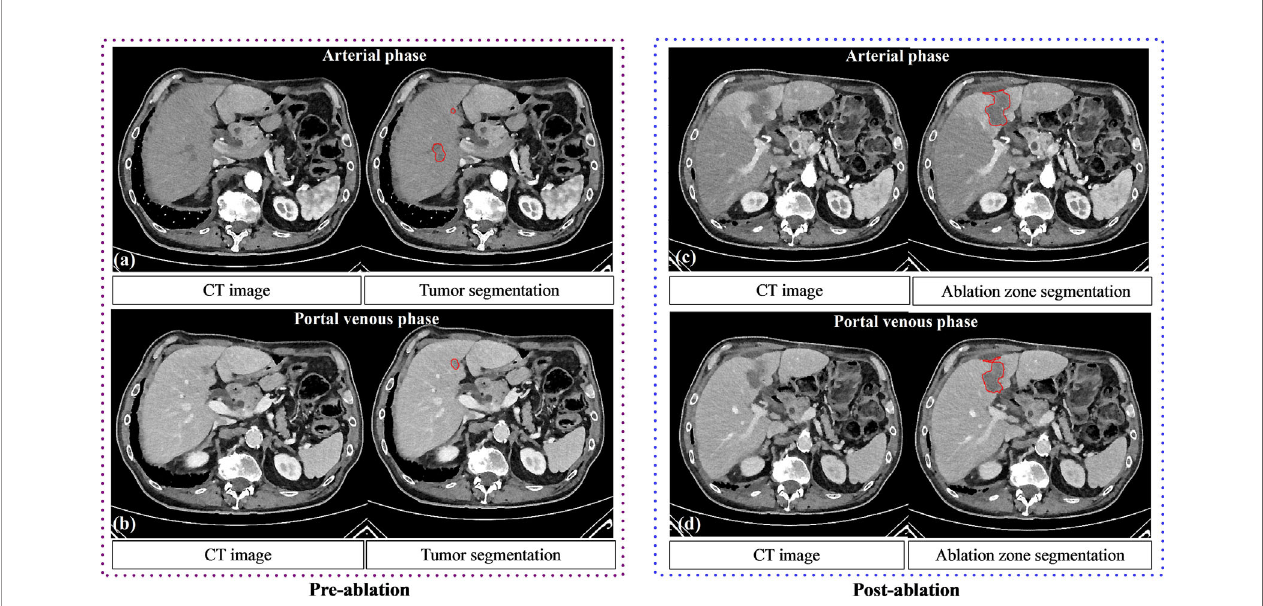
FIGURE 3 | The performance of tumor segmentation and ablation zone segmentation. Pre (A, B) and post (C, D) ablation contrast CT of a 65-year-old male patient with liver metastases. Tumor and ablation segmentations using the deep learning model are